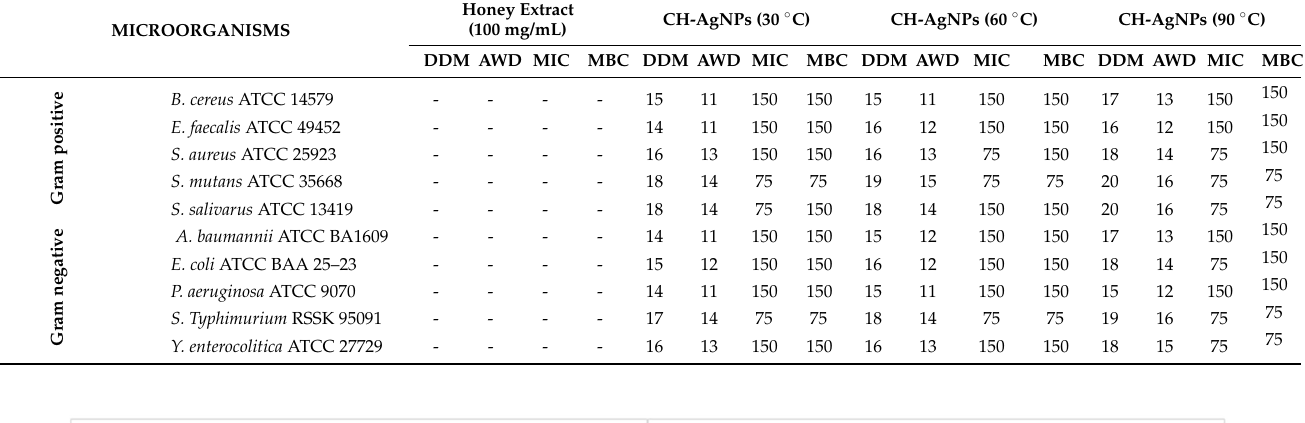
Table 5. In vitro antibacterial activity assays results of CH-AgNP samples. [Disk diffusion method (DDM); agar well diffusion method (AWD—mm); minimum inhibition concentration (MIC— µ g/mL) and minimum bactericidal concentration (MBC— µ g/mL)].